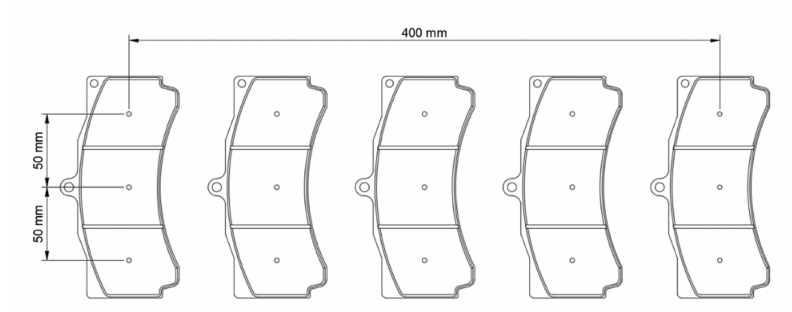
Figure 13. Distance of Each Brake Pad and its Testing